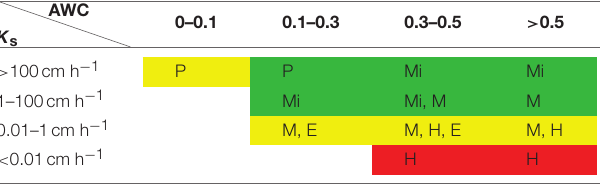
TABLE 1 | Hydrological classification of degraded peat soils based on saturated hydraulic conductivity ( K s ) and available water capacity (AWC, cm 3 cm − 3 ). AWC 0–0.1 0.1–0.3 0.3–0.5 > K s